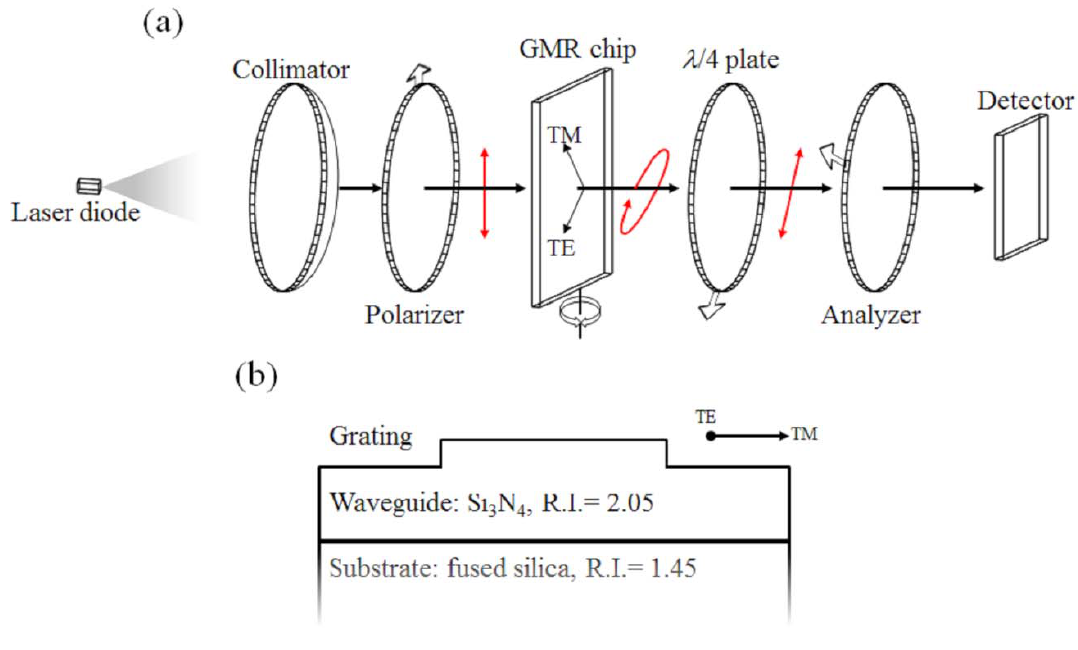
Figure 1. ( a ) Setup of the polarization control system. The arrows sketched on the polarizer, analyzer and quarter wave plate stand for the transmission directions and fast axis, respectively. The red arrows drawn on light path depict the polarization states of the light wave. ( b ) Sketch of surface relief GMR chip, one period is